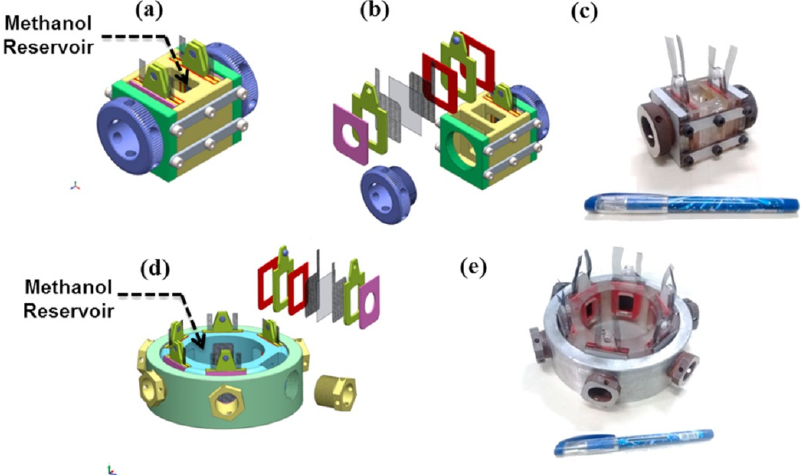
Figure 13. Schematic of novel quick-fit PS-DMFCs stacks: ( a ) configuration of the two-cell mini-stack; ( b ) exploded view depicting the various components and ( c ) picture of the device; ( d ) configuration of the six-cell mini-stack and ( e ) picture of the device. Reproduced from [145] with permission from Elsevier 2021.